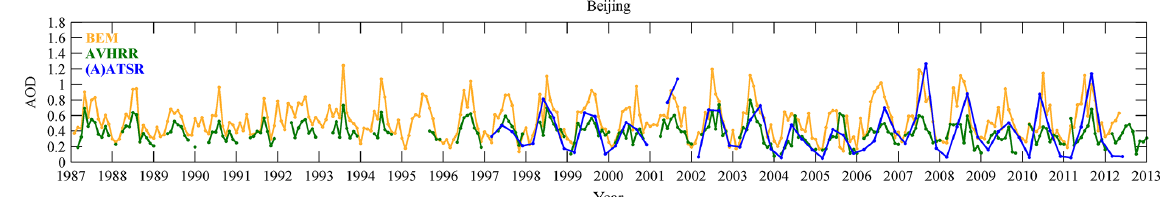
Figure 8. AOD time series for BEM (orange), with AVHRR (green) and (A)ATSR AOD (blue), over the Beijing site for the years